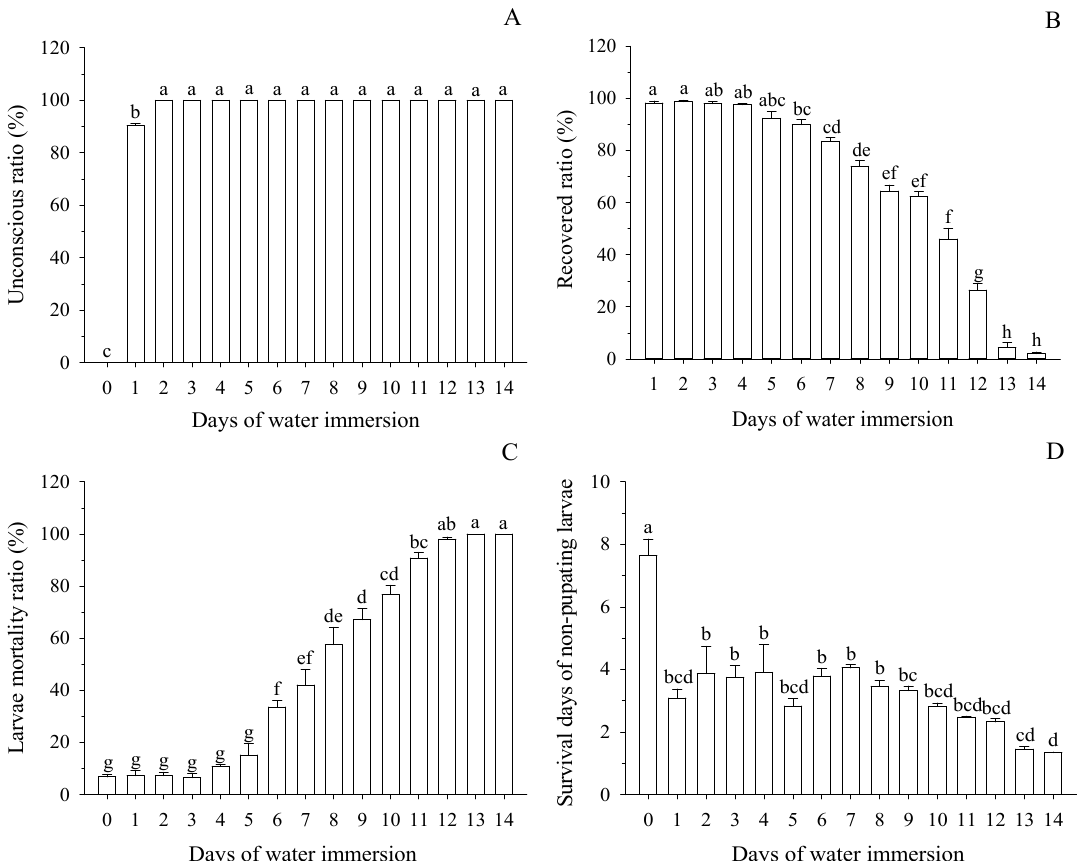
Figure 1. Effects of water immersion on the performance of mature larvae. ( A ): Ratio of knocked-out larvae in different days of water immersion. ( B ): Recovery ratio of knocked-out larvae in 24 h after removal from the water. ( C ): Mortality of larvae in different days of water immersion. ( D ): Survival days of non-pupated immersed larvae in different days of water immersion. Means (±SE) among different days of water immersion followed by different letters differ at p < 0.05 (Tukey HSD test).